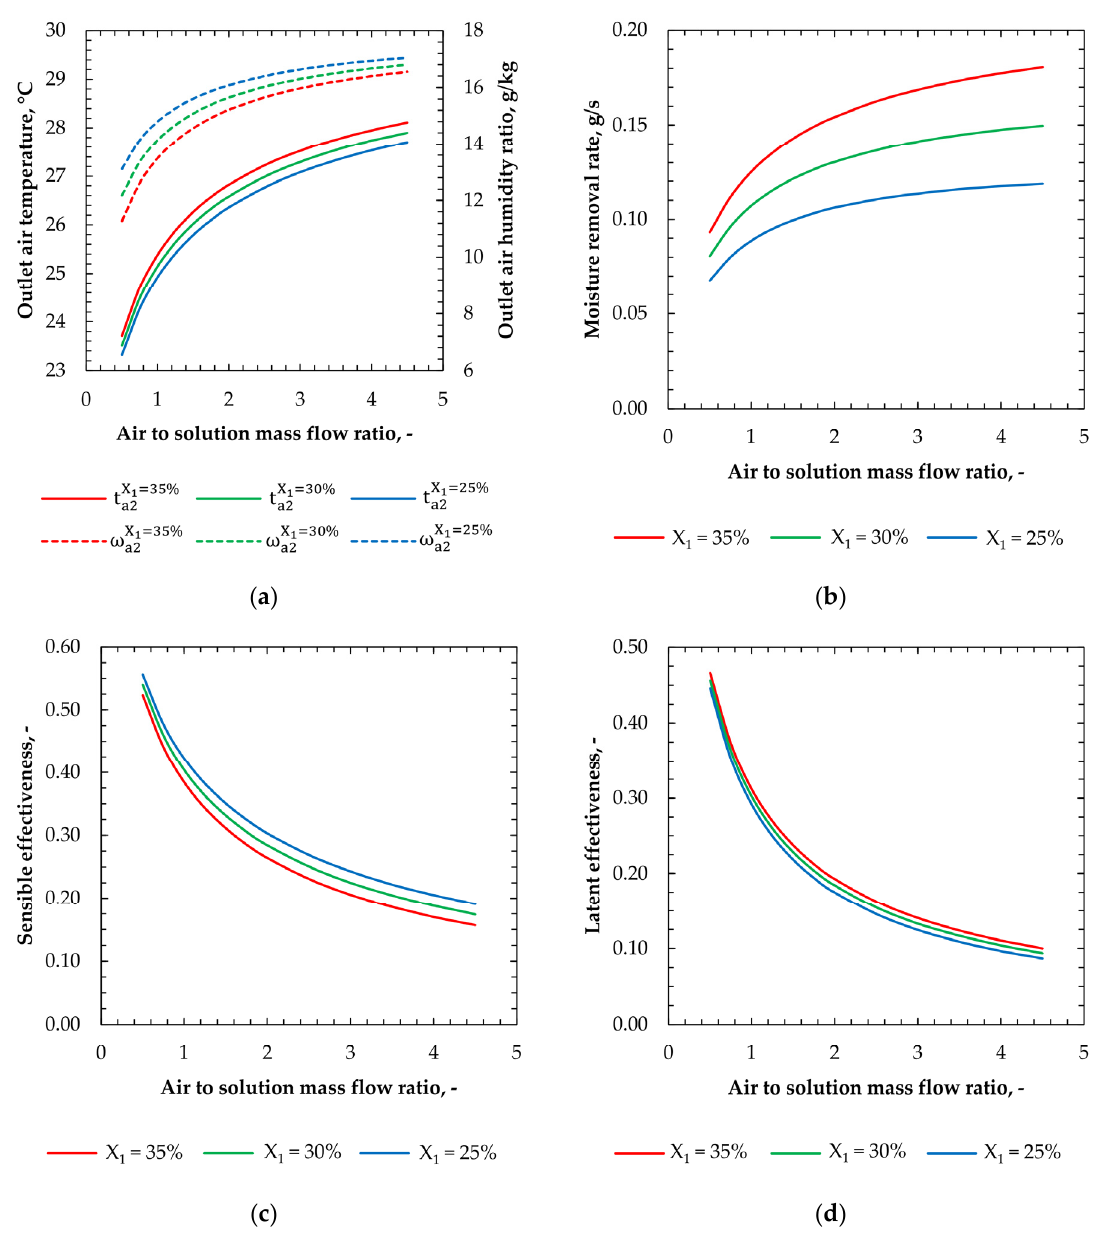
Figure 9. Effect of air to solution mass flow ratio in regard to different solution concentrations: ( a ) on outlet air temperature and outlet air-humidity ratio; ( b ) on moisture removal rate; ( c ) on sensible effectiveness; ( d ) on latent effectiveness.